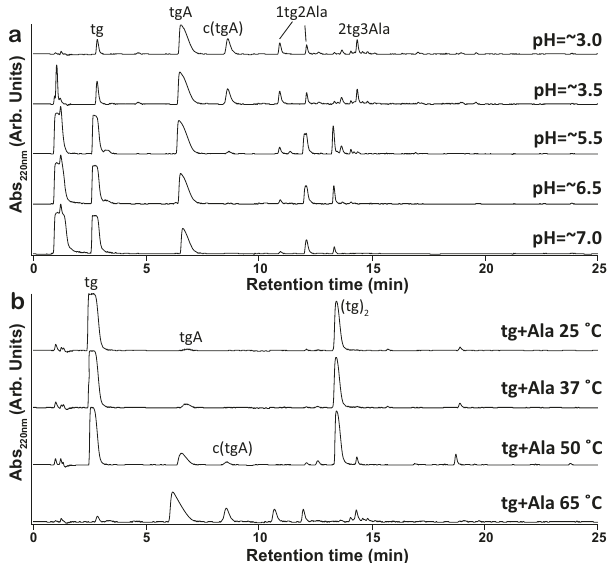
Fig. 5 Thiodepsipeptides form under a range of pH conditions and temperatures. a Chromatograms of products resulting from thioglycolic acid (tg) and alanine (Ala), in a 5:1 molar ratio, being dried at 65 °C for 1 week in various initial reactions pH. Products are observed throughout the whole range of pH conditions tested. b Chromatograms illustrating the temperature dependence of thiodepsipeptide formation under unbuffered, acidic conditions (pH ~3). Products are detected when mixtures of tg and Ala are dried and maintained at temperatures as low as 25 °C. (tg) 2 refers to a thioester-containing homodimer of tg. c(tgA) is the cyclic form of tgA, i.e., yields were low, some product formation was still observed at pH 9.0 and even at pH 12.5 (Supplementary Fig. 43).